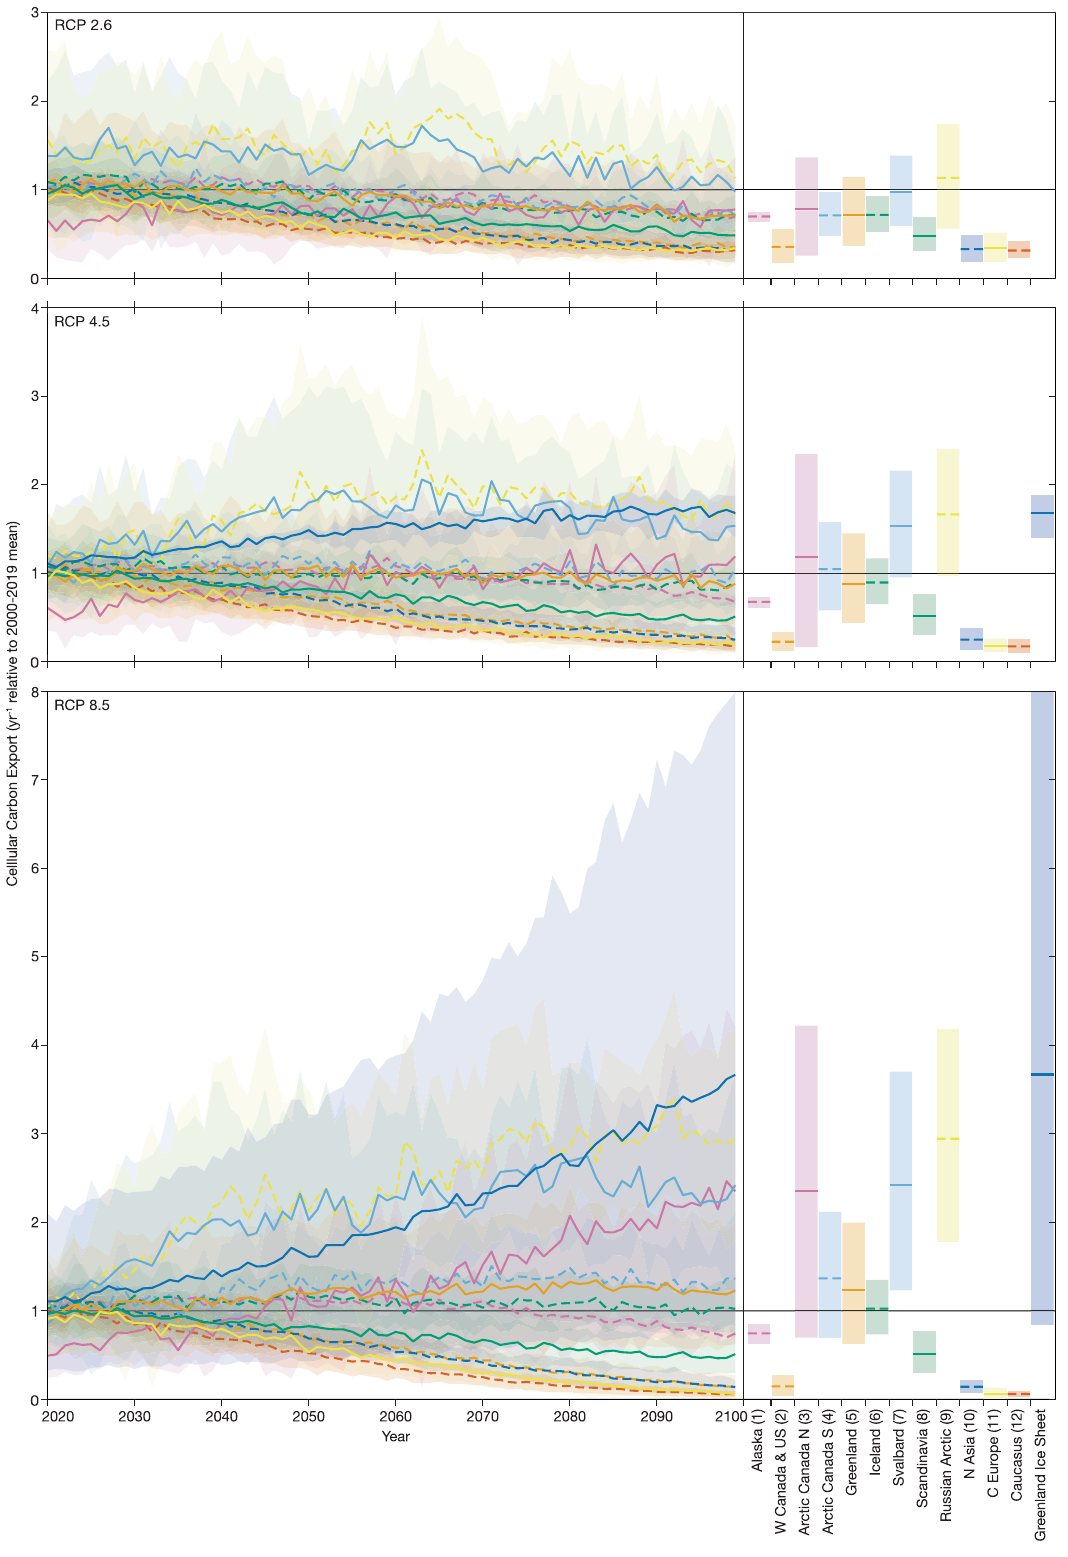
Fig. 5 Cellular carbon export trends under low, medium and high emissions scenarios (RCPs 2.6, 4.5 and 8.5) from 2020 to 2099, relative to the regional mean for 2000 – 2019. Note these trends also re fl ect relative changes in the absolute number of microbes exported. The right-hand panel depicts the mean and ± uncertainty in 2099 for the corresponding region. Note that there is no projection for the Greenland Ice Sheet under RCP 2.6. Solid lines indicate directly sampled regions, whilst dashed lines indicate extrapolated regions. Note that regions of equal colour are not connected in any fashion, the reuse of colour is a function of inherent colour palette